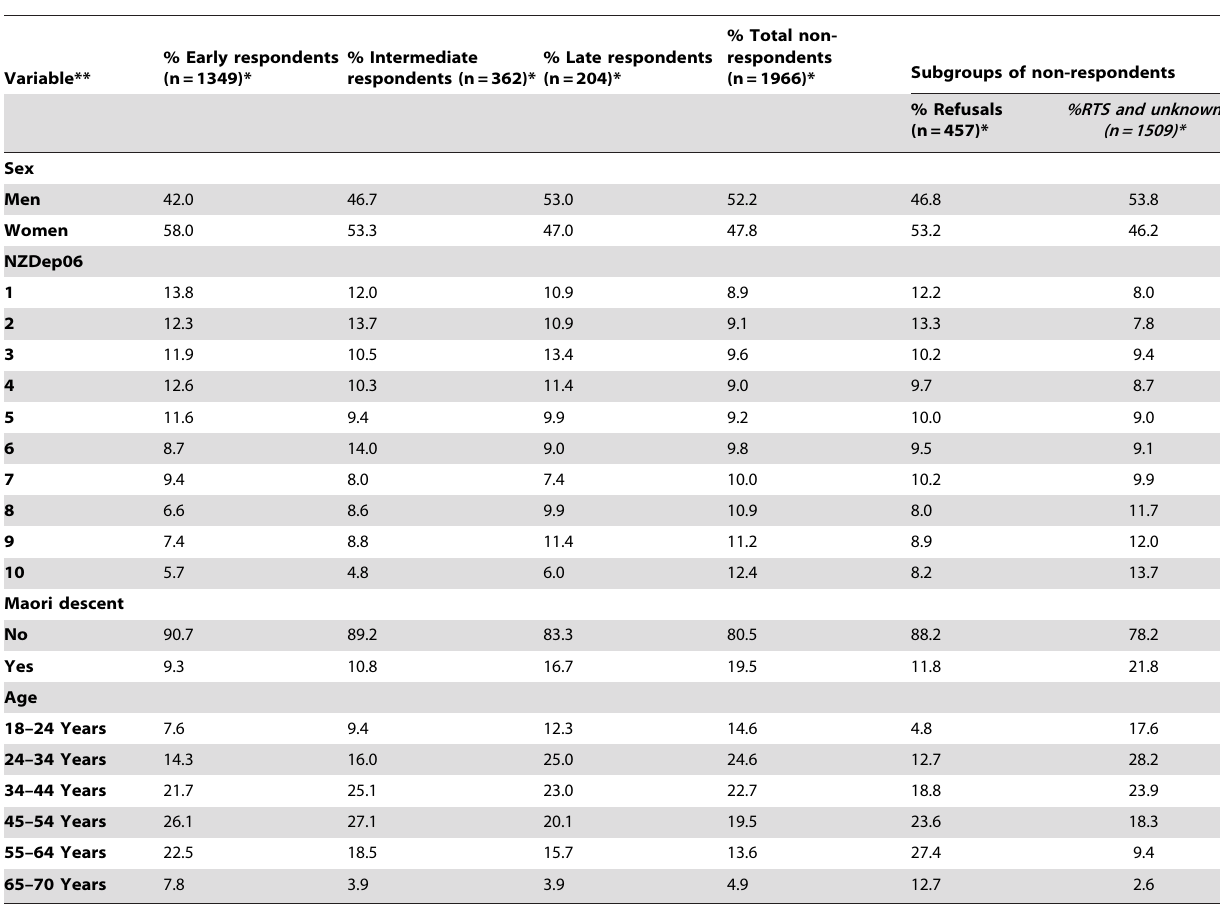
Table 2. Comparison of demographic characteristics across response